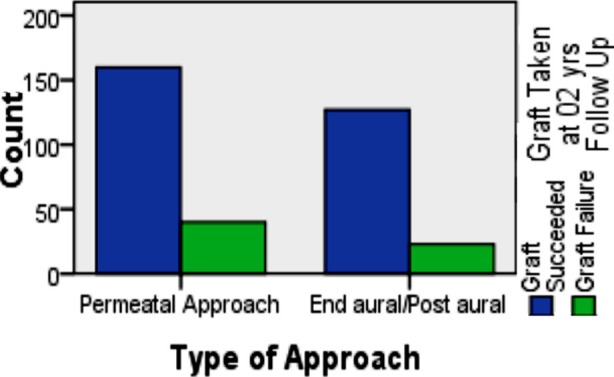
Comparison between Type of Approach & Graft Success on 2 Years’ follow-up.